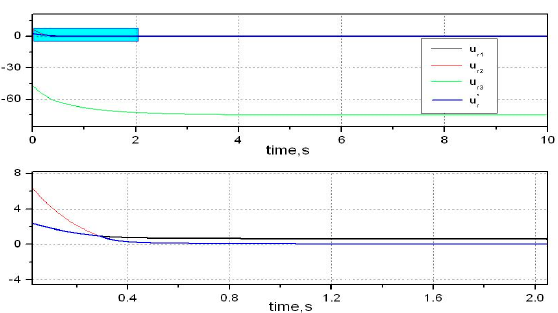
Figure 9. Output response with OAMTC limit regulator: positive set-point change. ( a ) Fan speed response; ( b ) high-pressure turbine outlet temperature response; and ( c ) high-pressure compressor outlet static pressure response.